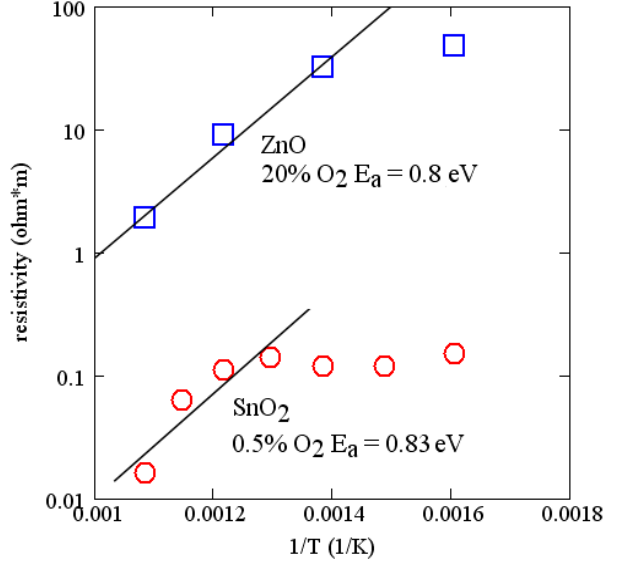
Figure 7. Measured resistivity for ZnO and SnO constant oxygen concentration.